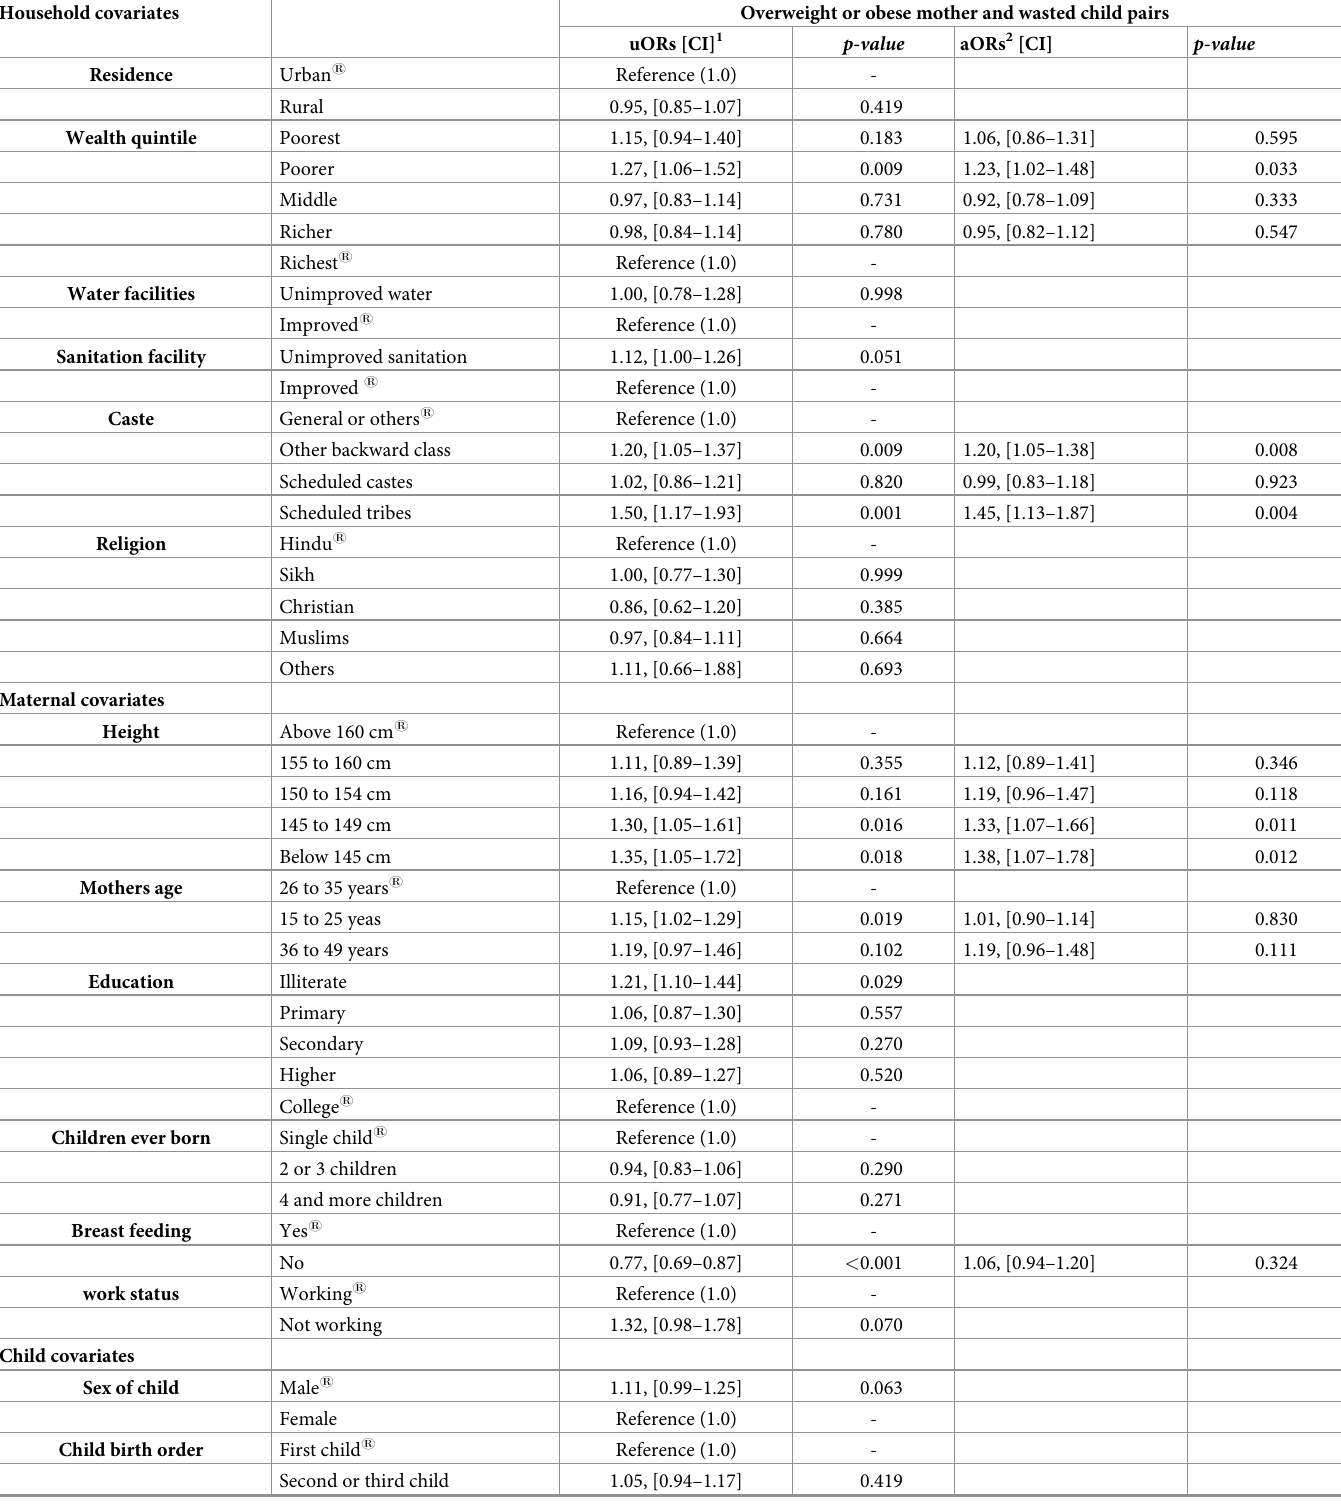
Table 5. Logistic regression results of overweight / obese mother and wasted child by familial, maternal and child covariates. Household